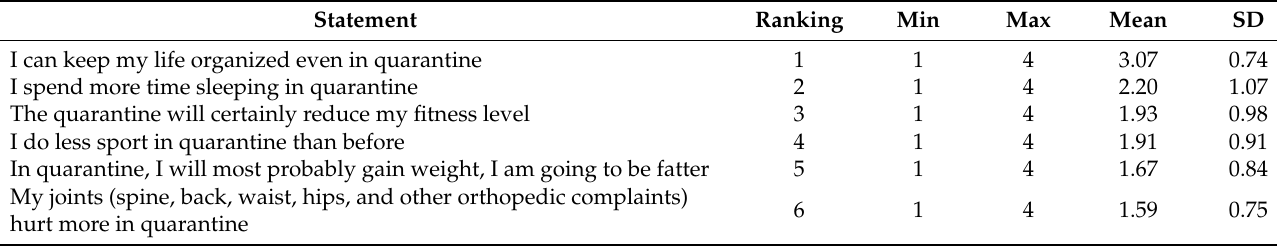
Table 4. Fitness and health in quarantine (N = 46).